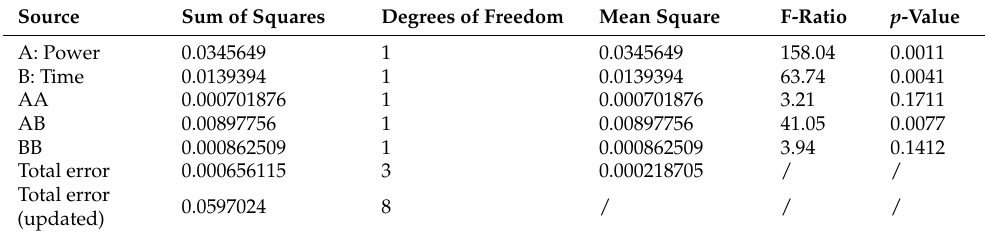
Table 6. Results of the test of statistical significance (ANOVA) of each factor of microwave extraction (MW) on the change in the concentration of total